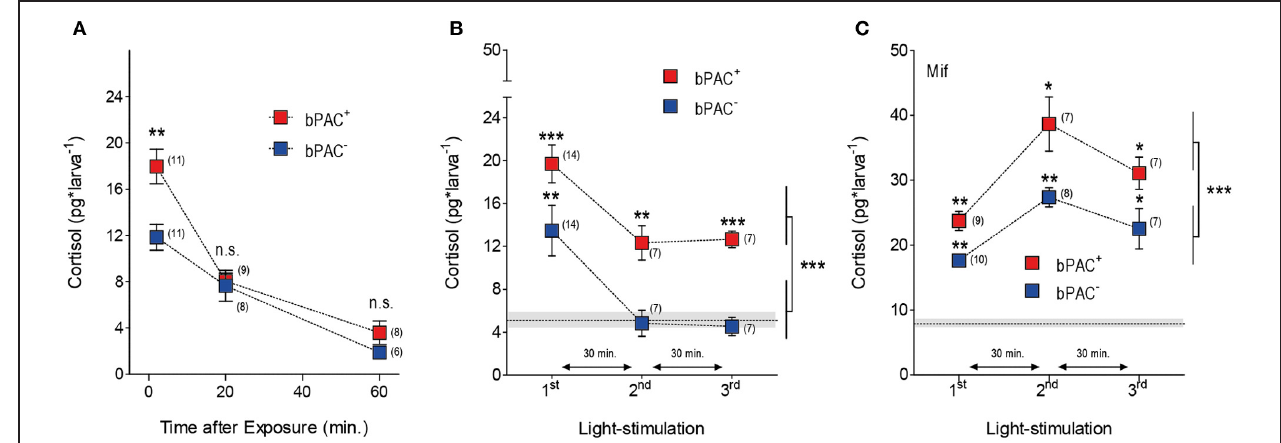
the GR antagonist mifepristone (Mif), both bPAC + and bPAC − larvae respond to multiple light stimulations with increased cortisol levels, which are, on average, substantially higher than those from non-incubated larvae (asterisks indicate statistical differences between groups at p < 0 . 05 or p < 0 . 01; light-power: 2.8mW ∗ cm − 2 ; inter-trial interval: 30min). (B,C) Mean basal cortisol level ± S.E.M. shown as a dotted line and gray background, respectively; note that basal cortisol levels are comparatively higher in the Mif-incubated